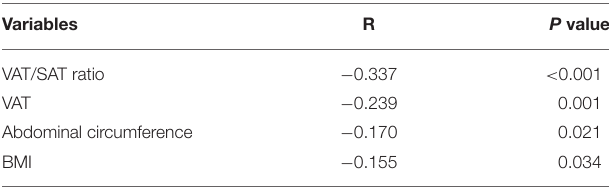
TABLE 3 | Spearman correlation analyses between adiponectin and VAT/SAT, VAT, abdominal circumference, and BMI. Variables R P value VAT/SAT ratio −